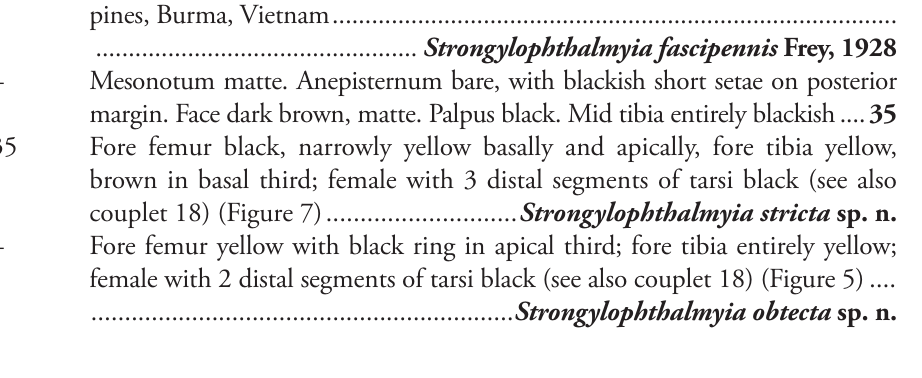
Descriptions of new species Strongylophthalmyia annulipes sp. n. http://zoobank.org/6F1961E2-9838-4C98-A1BE-4B348AD527F5 Figure 1 Type material. Holotype: 1 male, Vietnam, Lai Châu Province, Hoáng Liên (22.34997°N, 103.76818°E), 1947 m, 11.IV.2012 (D. Gavryushin). Paratypes: 2 female, Vietnam, Lai Châu Province, Hoáng Liên (22.347948°N, 103.769714°E), 1900 m, 16.IV and 19.IV.2012 (A.L. Ozerov); 1 male, 1 female, Vietnam, Lai Châu Province, Hoáng Liên (22.33788°N, 103.77922°E), 2068 m, 21.IV. and 7.V.2013 (T.V.Galinskaya). ZMUM. Diagnosis. This new species belongs to a group of species characterized by a yel- low postpronotum, propleuron and basisternum. Three species from this group, S. hu- meralis , S. bifasciata and S. yaoshana are otherwise characterized by an arista with very short setulae and easily differentiated. Other species of this group, S. spinosa , S. thaii , S. coarctata Hendel, 1913 and S. macrocera differ from S. annulipes by transparent wings. Strongylophthalmyia annulipes sp. n. is close to S. tomentosa sp. n. and differs from it by the presence of a preapical black ring on the mid and hind femora and by black ring on the mid and hind tibia. Description. Male. Head black, shining, slightly longer than its height; frons en- tirely black, covered with grey tomentose of by very short setulae (0.01 mm). Occiput slightly convex (in dorsal view). Face black, matte, with row of short setulae along suture; parafacial black, covered with silvery grey tomentum, length of its setulae: 0.021–0.028 mm. Gena with brownish short stripe directly below parafacial. Antenna brownish yellow. First flagellomere rounded, its length almost equal to height; dark brown, narrowly yellow at base, with short yellow setulae dorsally. Arista dark brown, bare. Palpi brownish yellow. Chaetotaxy: three reclinate to lateroclinate orbital setae (the middle seta 2.5 times longer than others), 1 ocellar seta, 1 postocellar seta, 1 inner vertical seta, 1 outer vertical seta, 2 hair-like short frontal